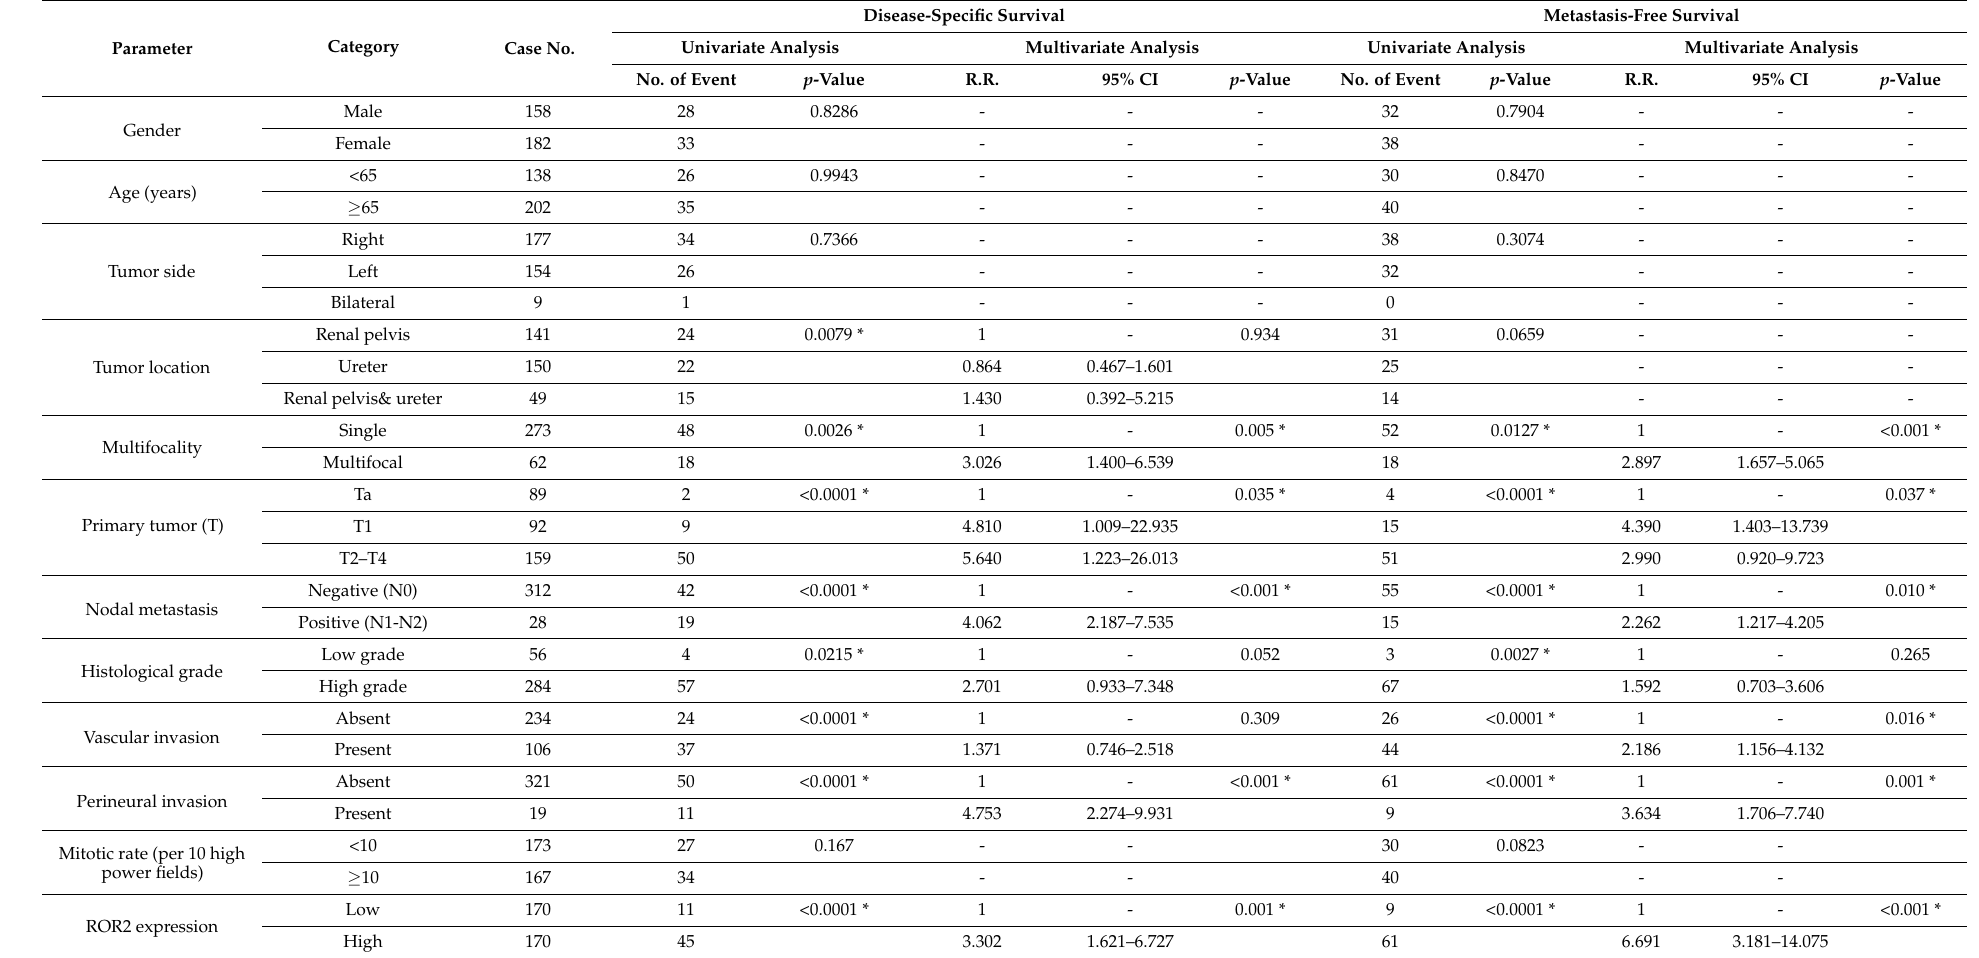
Table 3. Univariate log-rank and multivariate analyses for disease-specific and metastasis-free survival in upper urinary tract urothelial carcinoma.